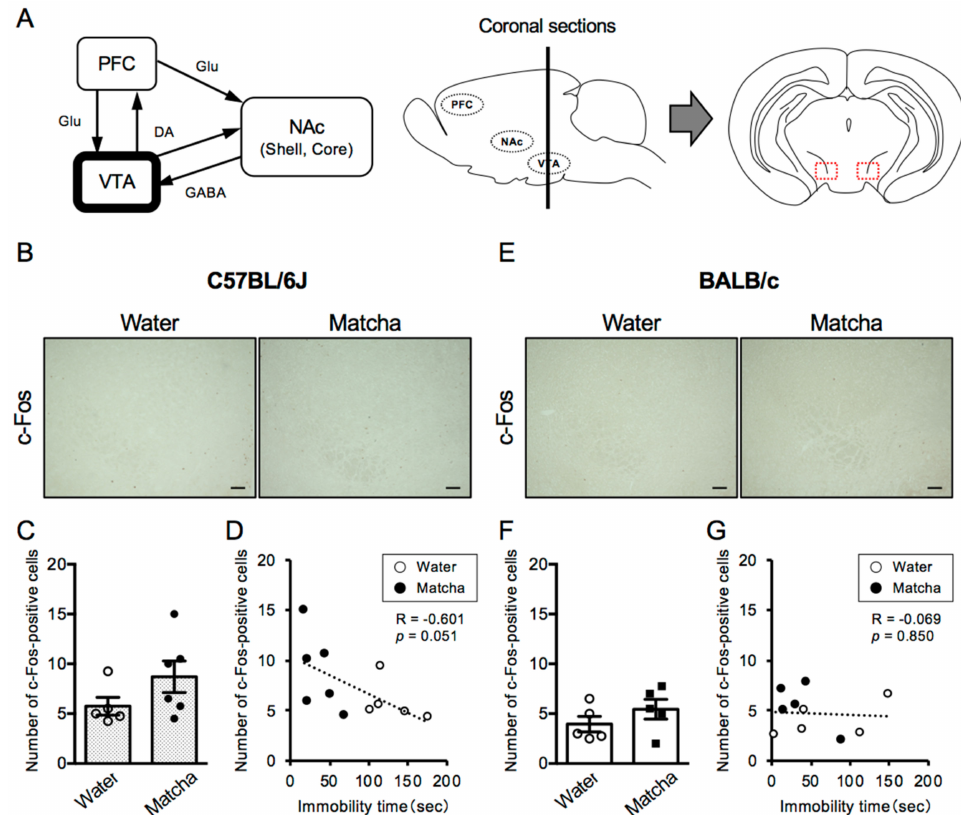
Figure 3. Effects of Matcha tea powder on the neural activity in the VTA region in C57BL/6J and BALB/c mice. ( A ) A schematic view of the PFC-NAc-VTA circuit (dopaminergic system). Dotted lines in red indicate the area of interest for image analysis of the number of c-Fos-positive cells in the VTA region. ( B , E ) Representative photographs showing immunohistochemistry on c-Fos in the VTA region 2 h after Matcha tea powder administration (100 mg/kg, p.o.). ( C , F ) The quantification of the number of c-Fos-positive cells is shown. The results are expressed as the means ± SEM. The data were analyzed by the unpaired t -test. n = 5–6 animals. ( D , G ) The correlation between immobility time in the TST and the number of c-Fos-positive cells in the VTA region is shown. Scale bars = 100 µ